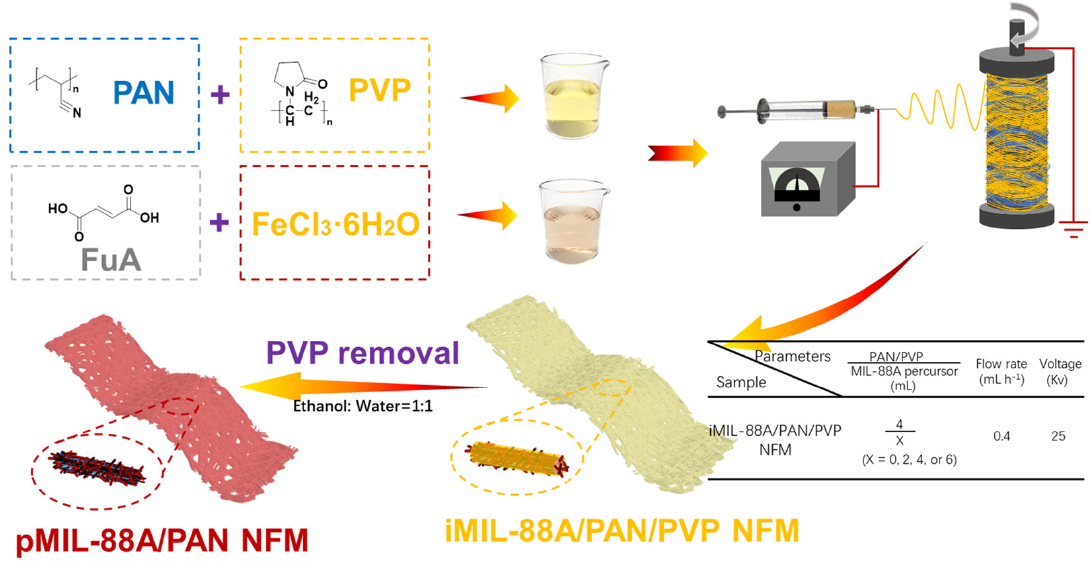
Figure 1. Schematic for the fabrication of pMIL-88A/PAN NFMs.